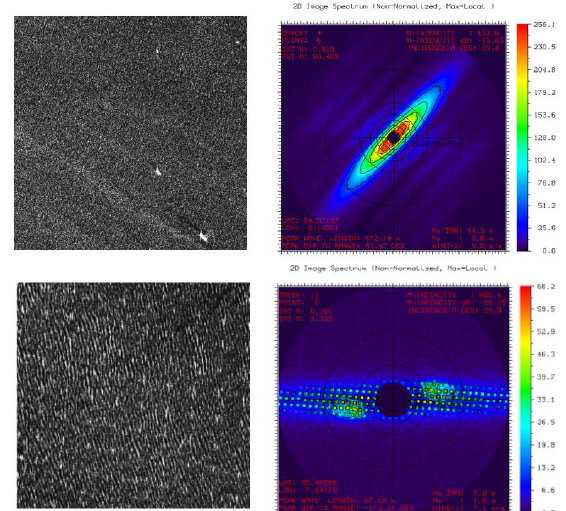
Figure 2. Examples of artefacts in TerraSAR-X sub-images (left) influence spectra (right) and consequently integrated energy: ships (above) and wind park (below). Without pre- filtering of such artefacts, wave height can be estimated several times higher than the surrounding H S